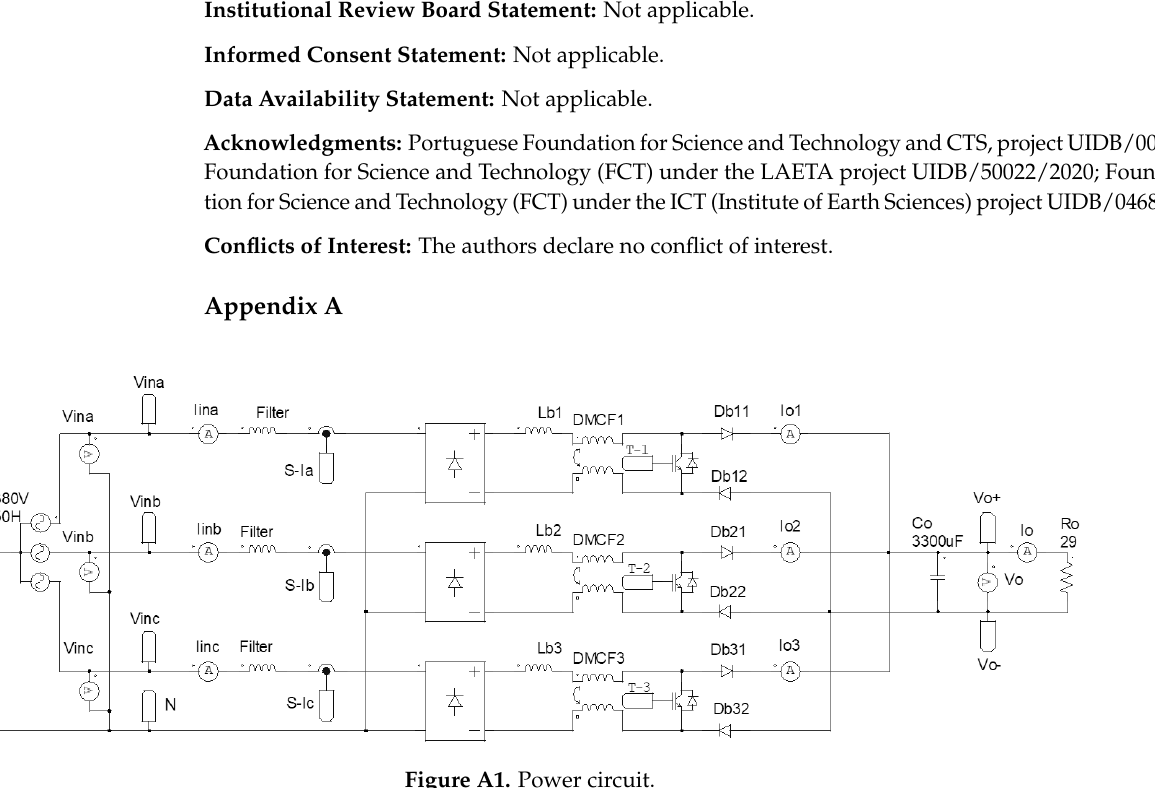
Figure A2. Interface circuit.